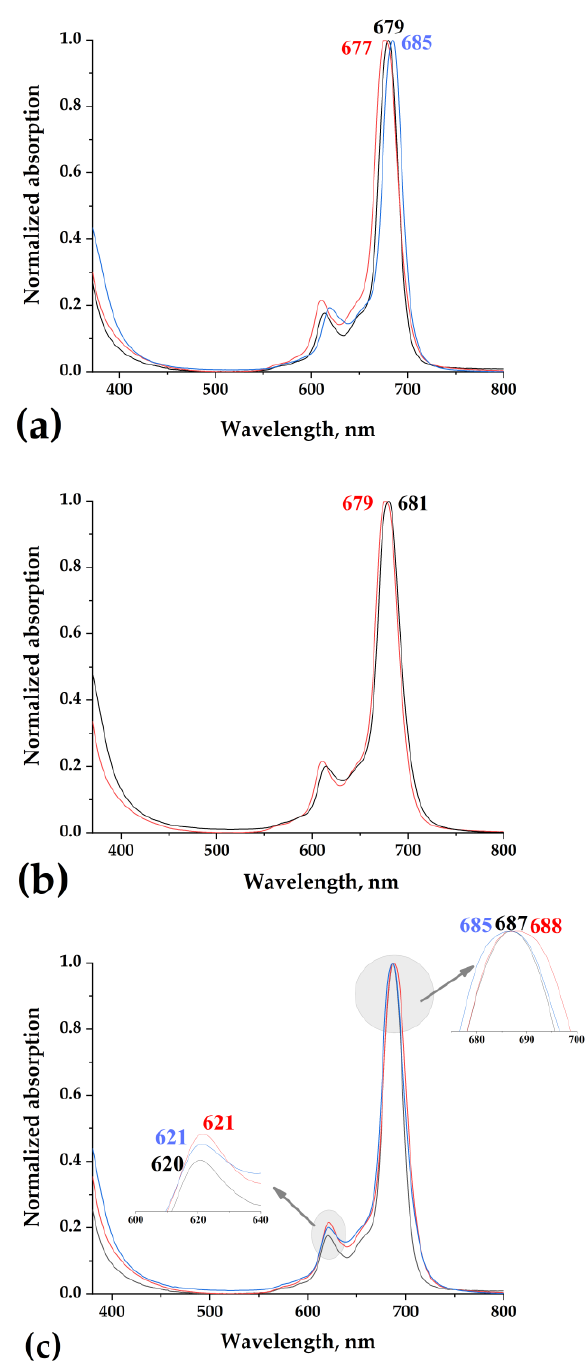
Figure 2. ( a ): Normalized electronic absorption spectra of compound 4 in acetone (red line), tetrahydrofuran (black line), and chloroform (blue); ( b ): Normalized electronic absorption spectra for compounds 4 (red line) and 7 (black line) in tetrahydrofuran; ( c ): Normalized electronic absorption spectra for compounds 4 , 5, and 6 in chloroform.